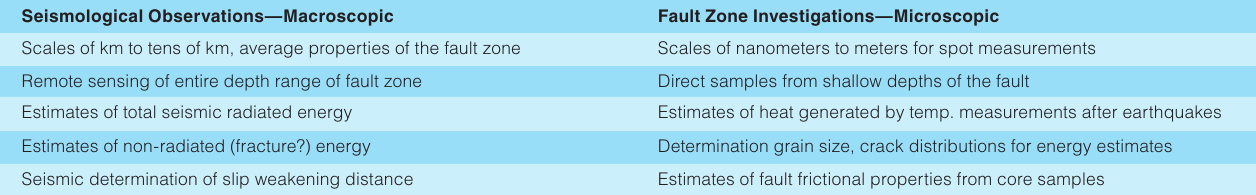
Table 1. Complementary differences between typical seismology studies and fault zone